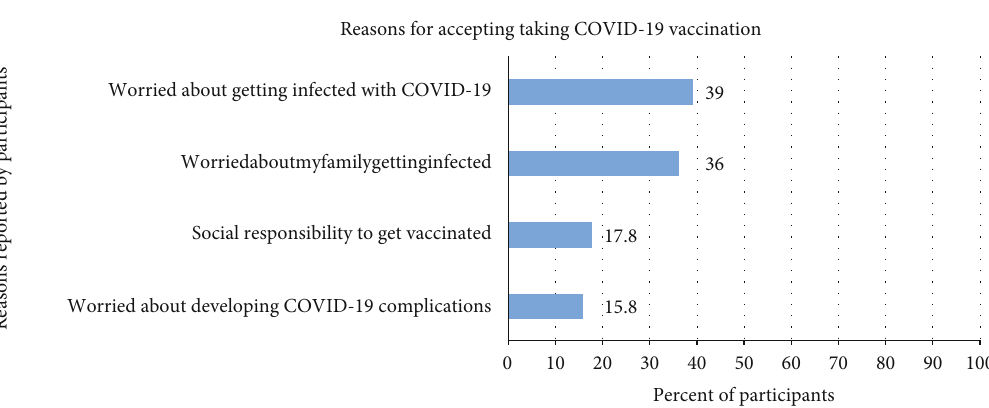
Figure 6: Reasons behind not taking COVID-19 vaccines as reported by participants ( n = 400